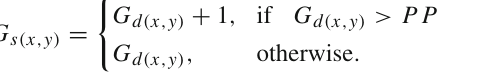
Compression algorithm plays a vital role in data embed-